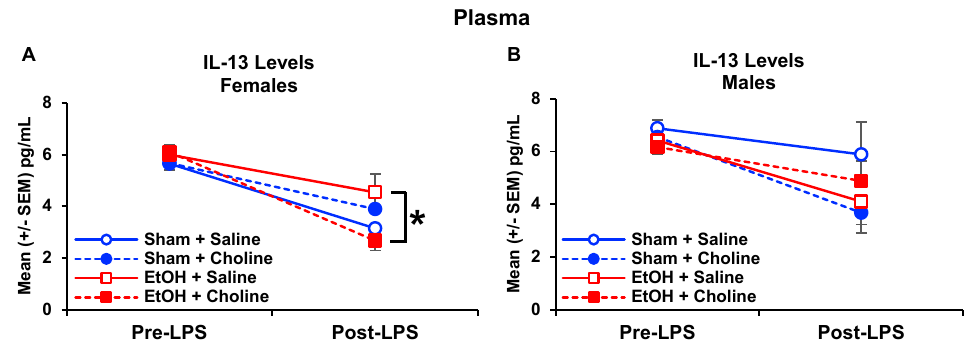
Figure 7. Sex differences in IL-13 plasma cytokine levels. ( A ) Females exposed to ethanol and treated with choline had lower IL-13 post-LPS (EtOH + Choline < EtOH + Saline, * p < 0.05). ( B ) No effects of ethanol exposure or choline supplementation were observed among males. n = 10–11 per group.